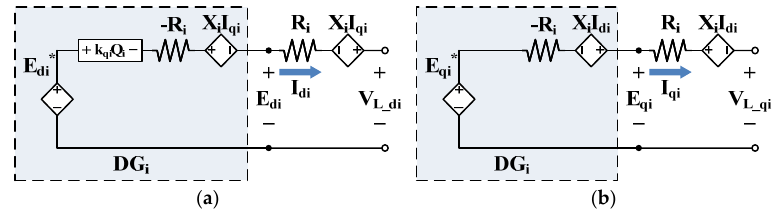
Figure 5. d ‐ q equivalent circuits for DG connected to load with line voltage drop feed ‐ forward compensation: ( a ) d ‐ axis; ( b ) q ‐ axis.